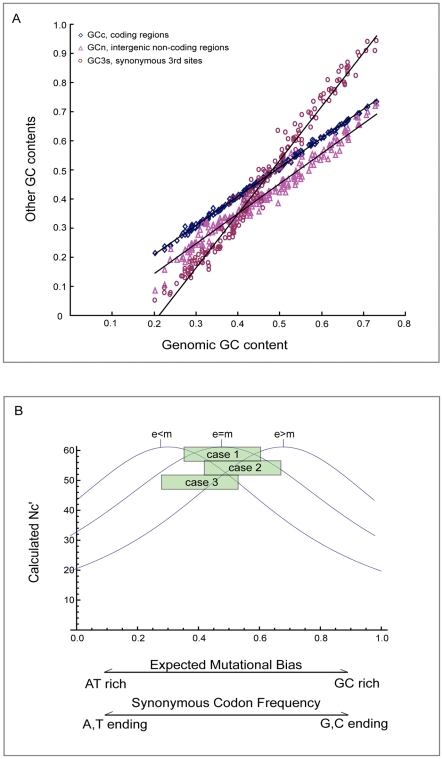
An internal problem of correlation method can lead to biased optimal codon identities.A. As genomic GC content increases, the GC contents of coding sequences (GCc), non-coding sequences (GCn), and synonymous 3rd codon position (GC3s) would change in different paces. B. Calculated Nc′ values change with relative synonymous codon frequency. The three curves represent three conditions: expected background mutational bias smaller than, equal to, or larger than real mutational bias. In case 1, selection has no effect on codon usage. In case 2, selection favors G, C-ending codons. In case 3, selection favors A, T-ending codons.